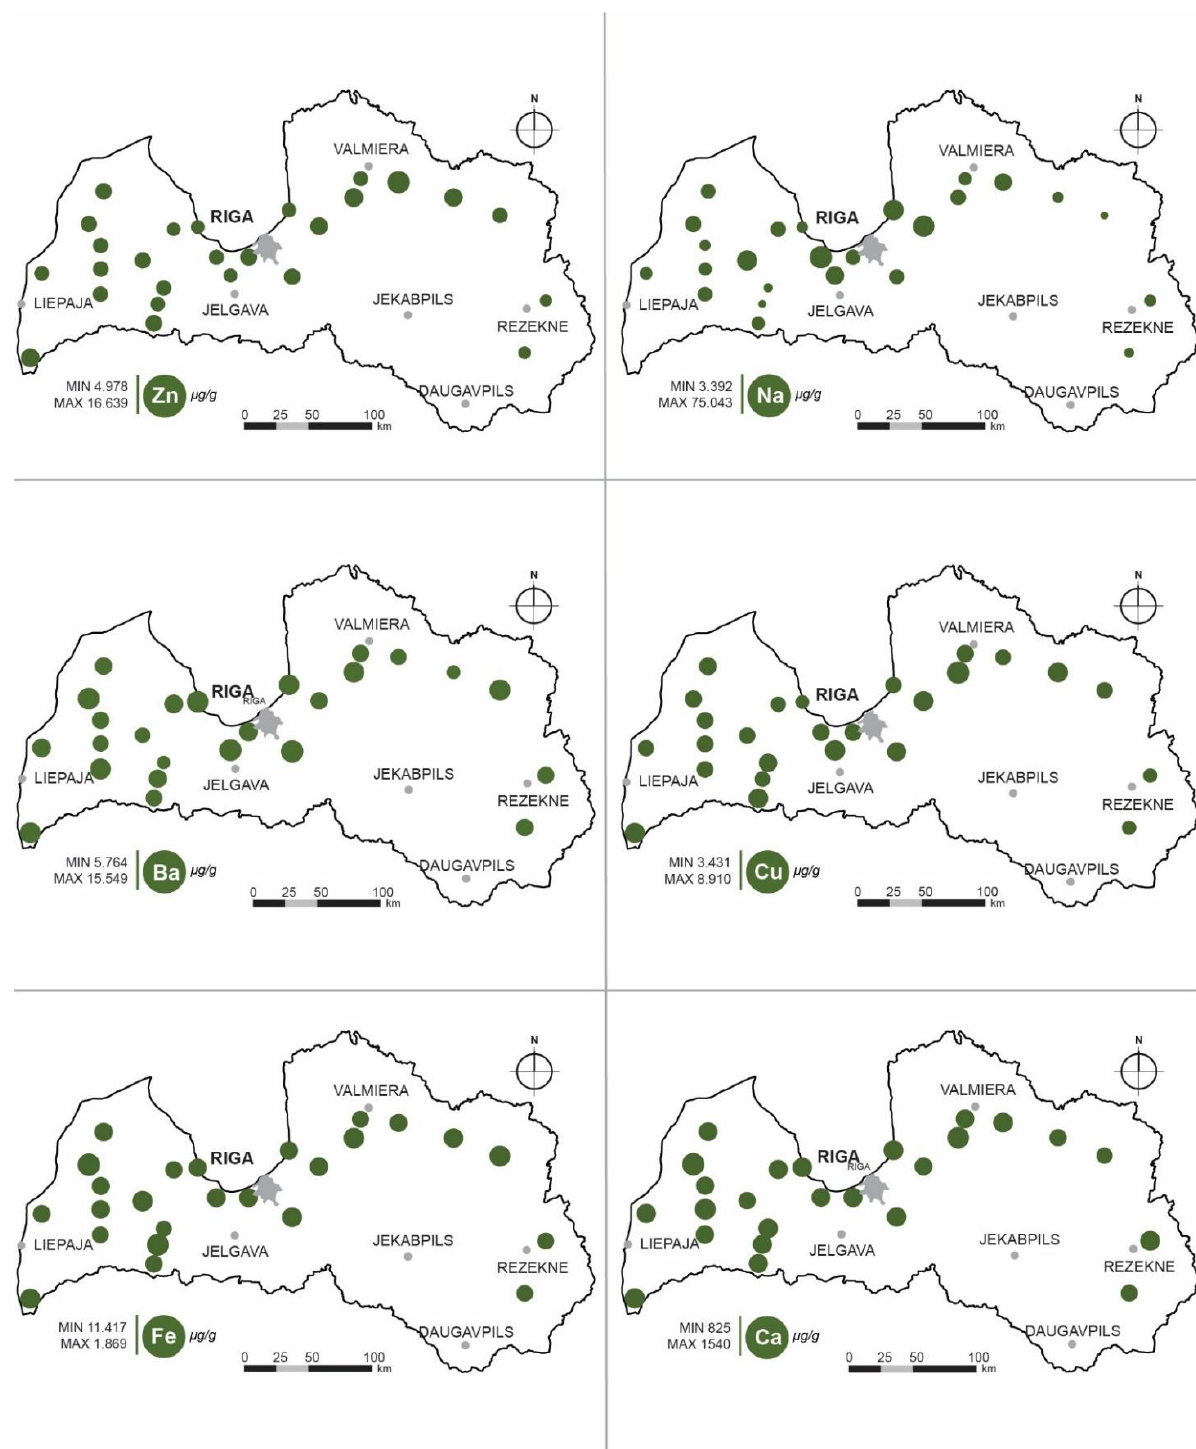
Figure 1. Elemental composition of bilberries in Latvia.